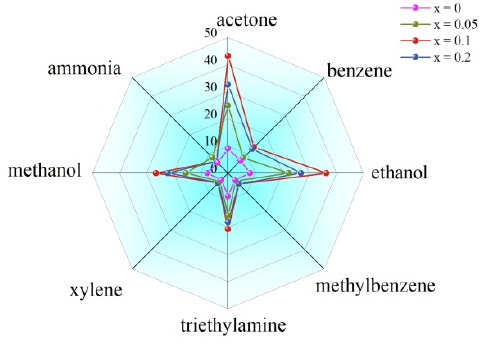
Figure 7. Selectivity of Bi 1 − x Er x FeO 3 sensors to different gases.